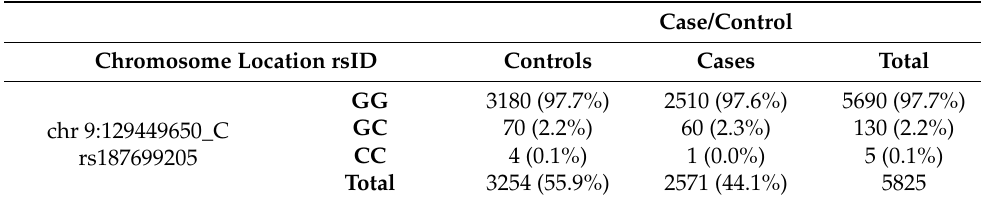
Table 1. Distribution of LMX1B genotypic variants between POAG cases and